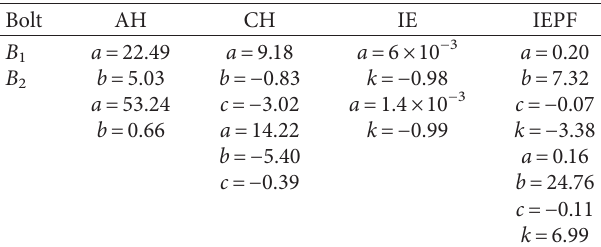
Table 7: Model parameters for example 1 .